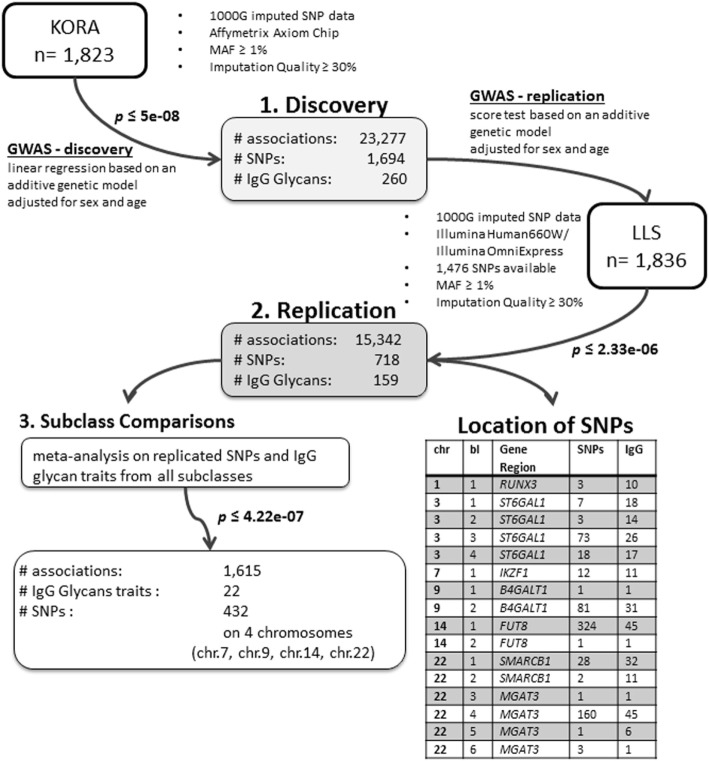
Overview of the study and analyses.